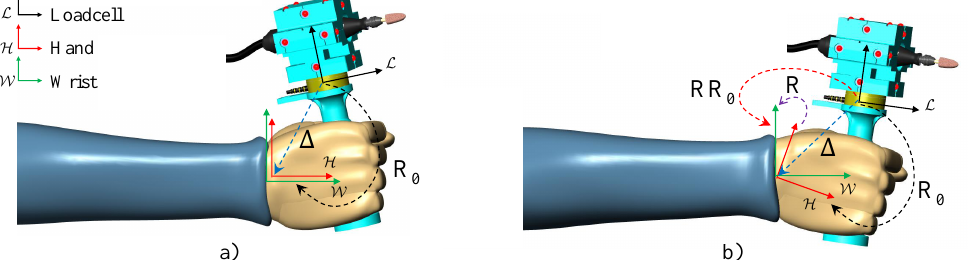
Figure 2. Neutral configuration of the hand. ( a ) Hand in neutral position; ( b ) Hand movement expressed by rotation